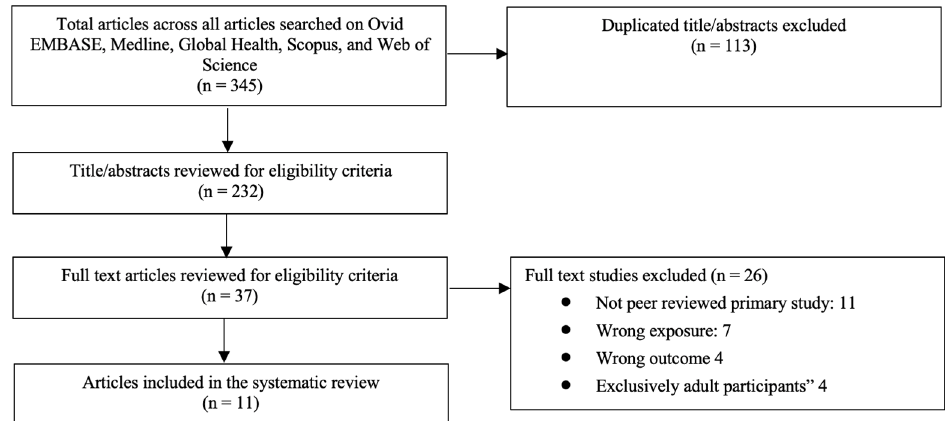
Figure 1. PRISMA flow diagram .